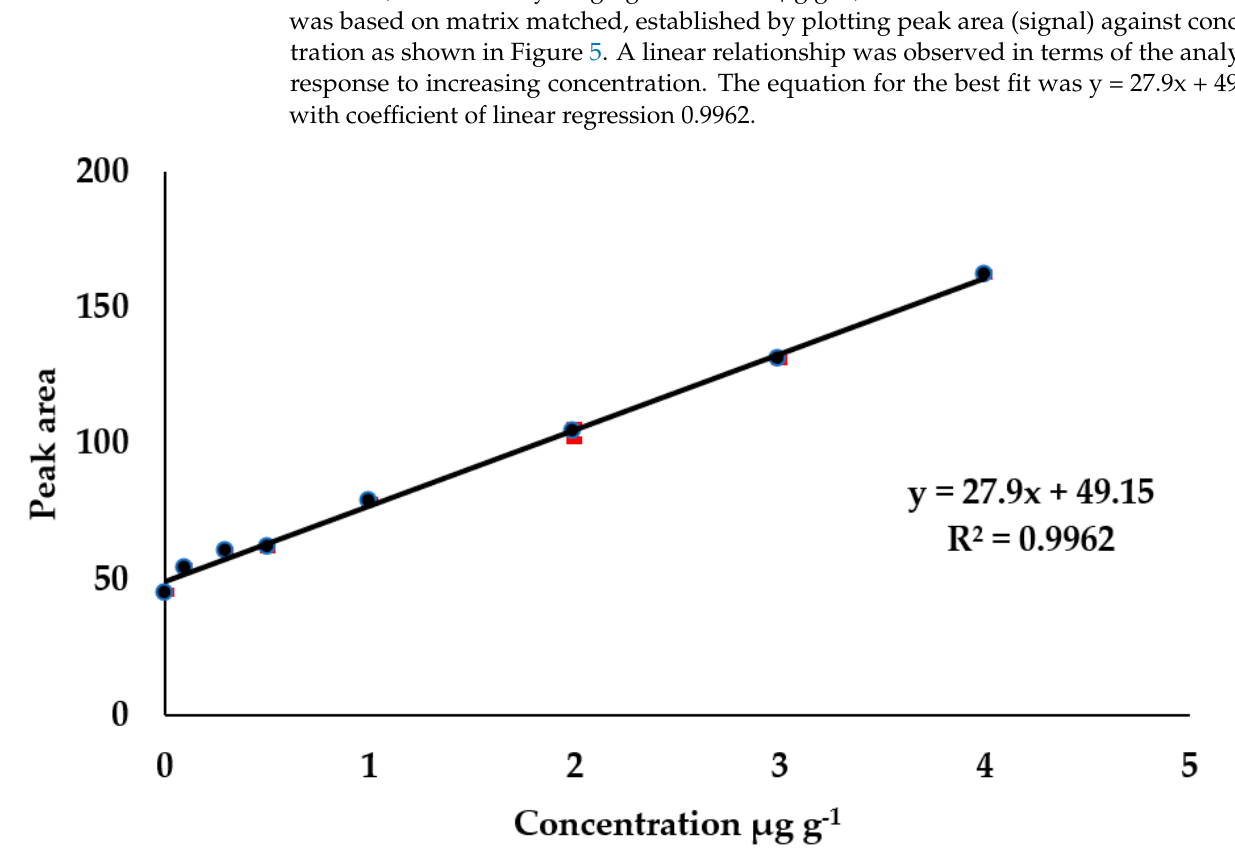
Figure 5. Calibration curve of peak area against C61-PCBM concentration in sediments; a matrix matched calibration curve.